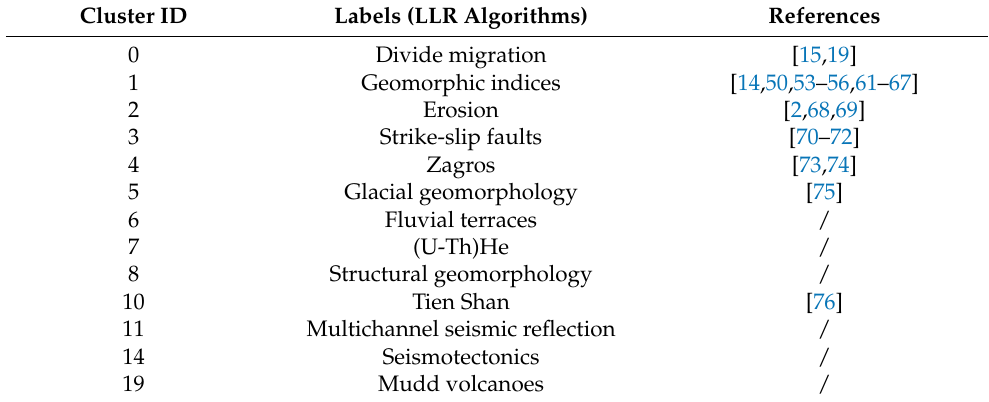
Table 9. The nodes in the Burst